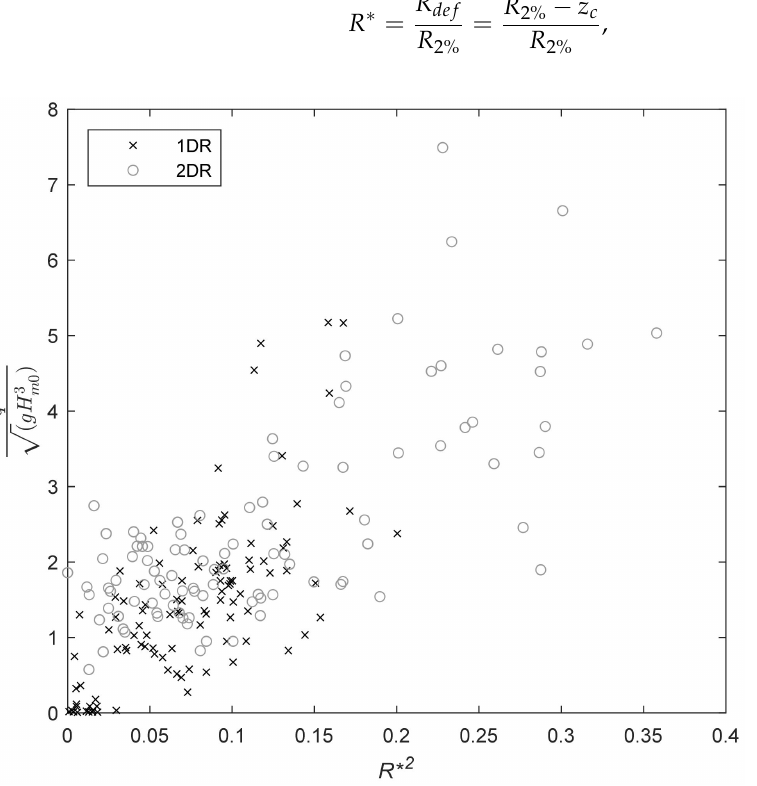
Figure 6. Overtopping discharge normalised using the EurOtop scaling [2] as a function of freeboard deficit R* 2 . Black crosses indicate 1DR data and grey circles